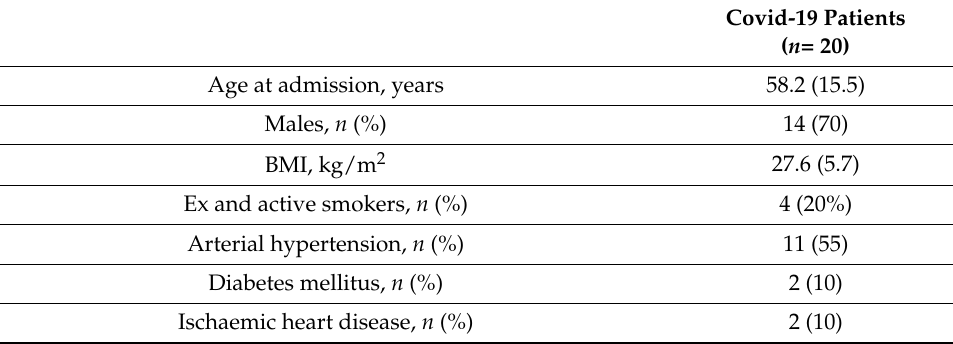
Table 1. Anthropometric, clinical characteristics, in-hospital treatments, and outcomes of patients included in the final